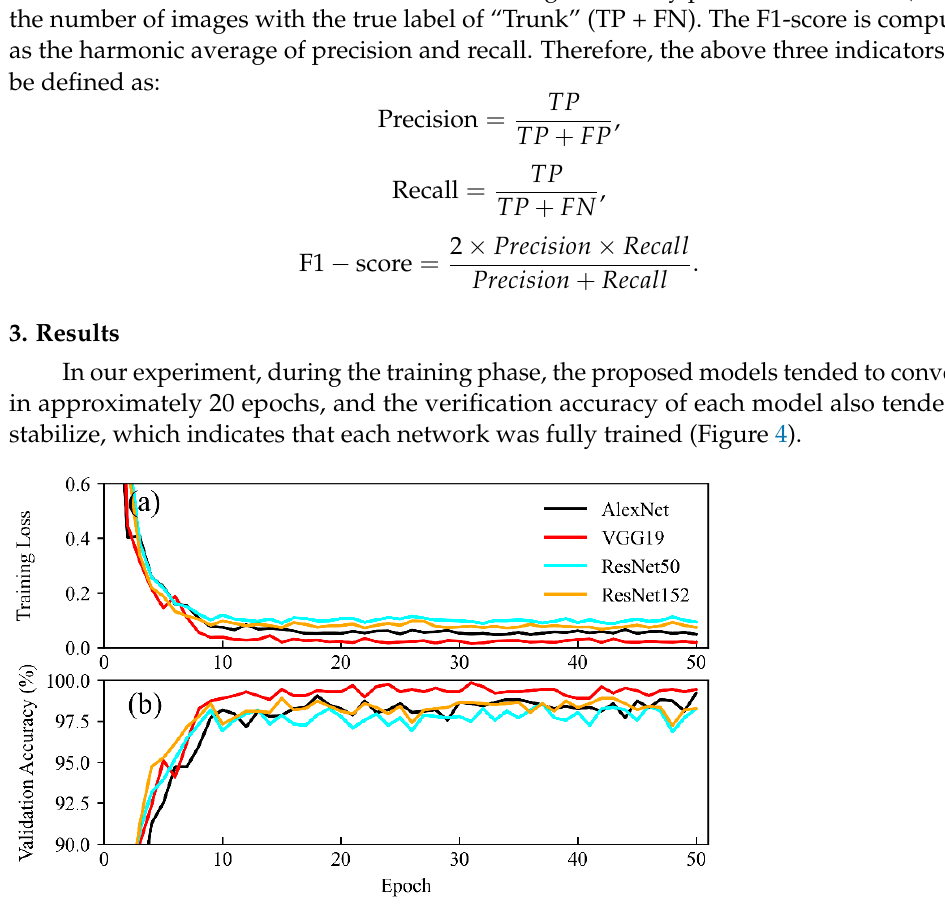
Figure 4. Training losses and accuracies of the tested models. ( a ) For each of the models, as the number of training rounds increased, the loss between the model’s predicted value and the true value showed a decreasing trend. ( b ) At the same time, the model’s accuracy on the validation set showed an upward trend. The models tended to converge in approximately 20 epochs, and the validation accuracy of each model also tended to stabilize, which indicates that the networks were fully trained.